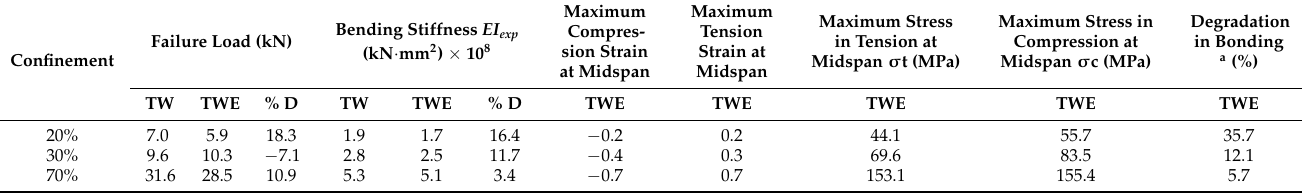
Table 4. Major experimental results of GFRP softwood poles specimens after 30 month of exposure to a high humidity environment (TWE) compared to some experimental results for specimens without humidity exposure (TW) [45].